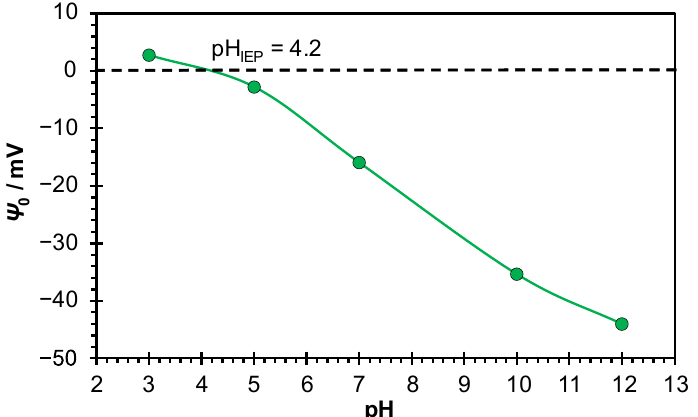
Figure 7. Inner surface potential of Ti/TiO 2 ( Ψ 0 /mV) in 1 × 10 − 3 mol dm − 3 NaCl aqueous solutions of different pH, at 25 °C. The isoelectric point of Ti/TiO 2 layer (pH iep = 4.2 [22]) was used to calculate Ψ 0 from E OC .